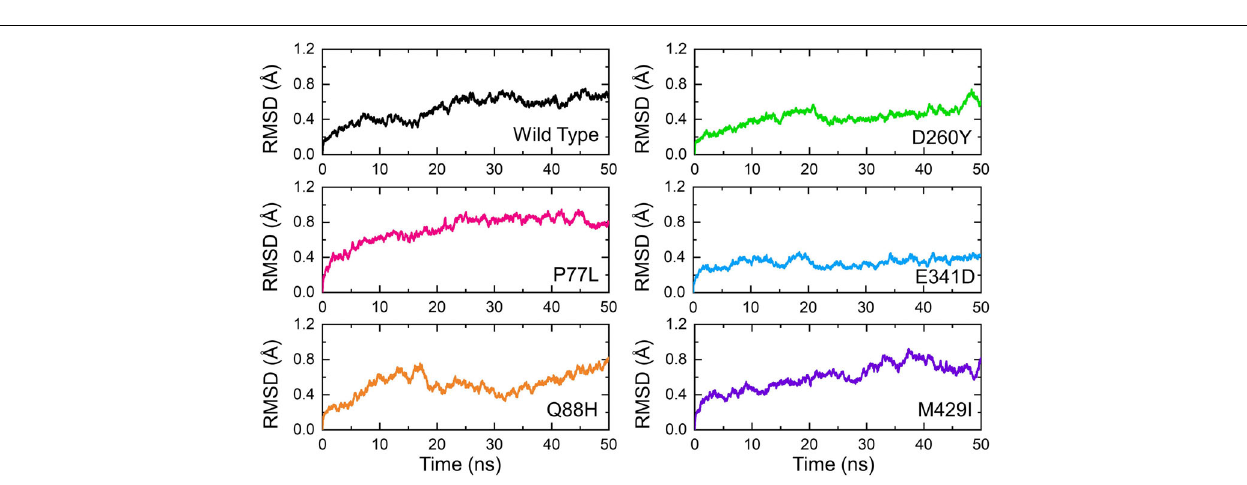
FIGURE 4 | E341D and M429I mutant complex docking. (A) E341D mutant and TBK1 key hydrogen bonding interactions and stick representations of bonds (left). Salt bridges, hydrogen bonding, and non-bonded interactions are shown by a 2D interaction (right). (B) M4291 mutant and TBK1 key hydrogen bonding interactions and stick representations of bonds (left). Salt bridges, hydrogen bonding, and non-bonded interactions are shown by a 2D interaction (right).